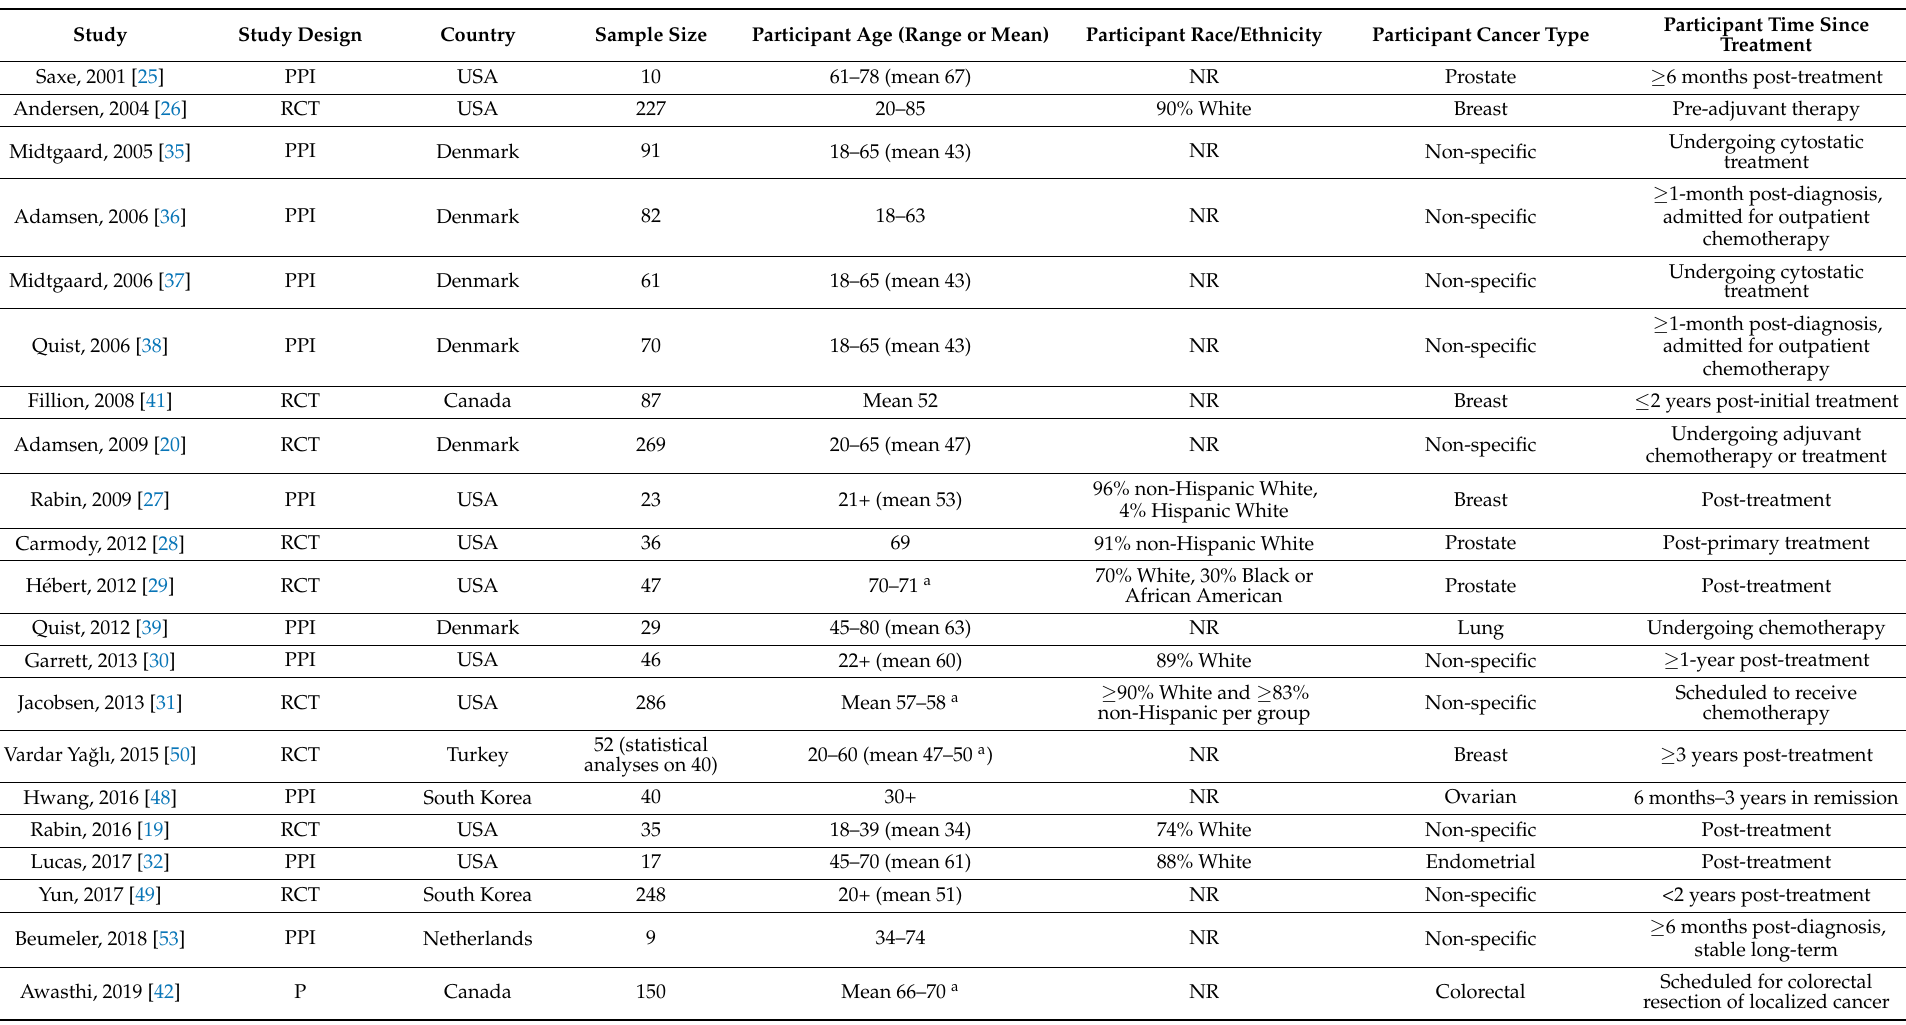
Table 1. Features of the studies